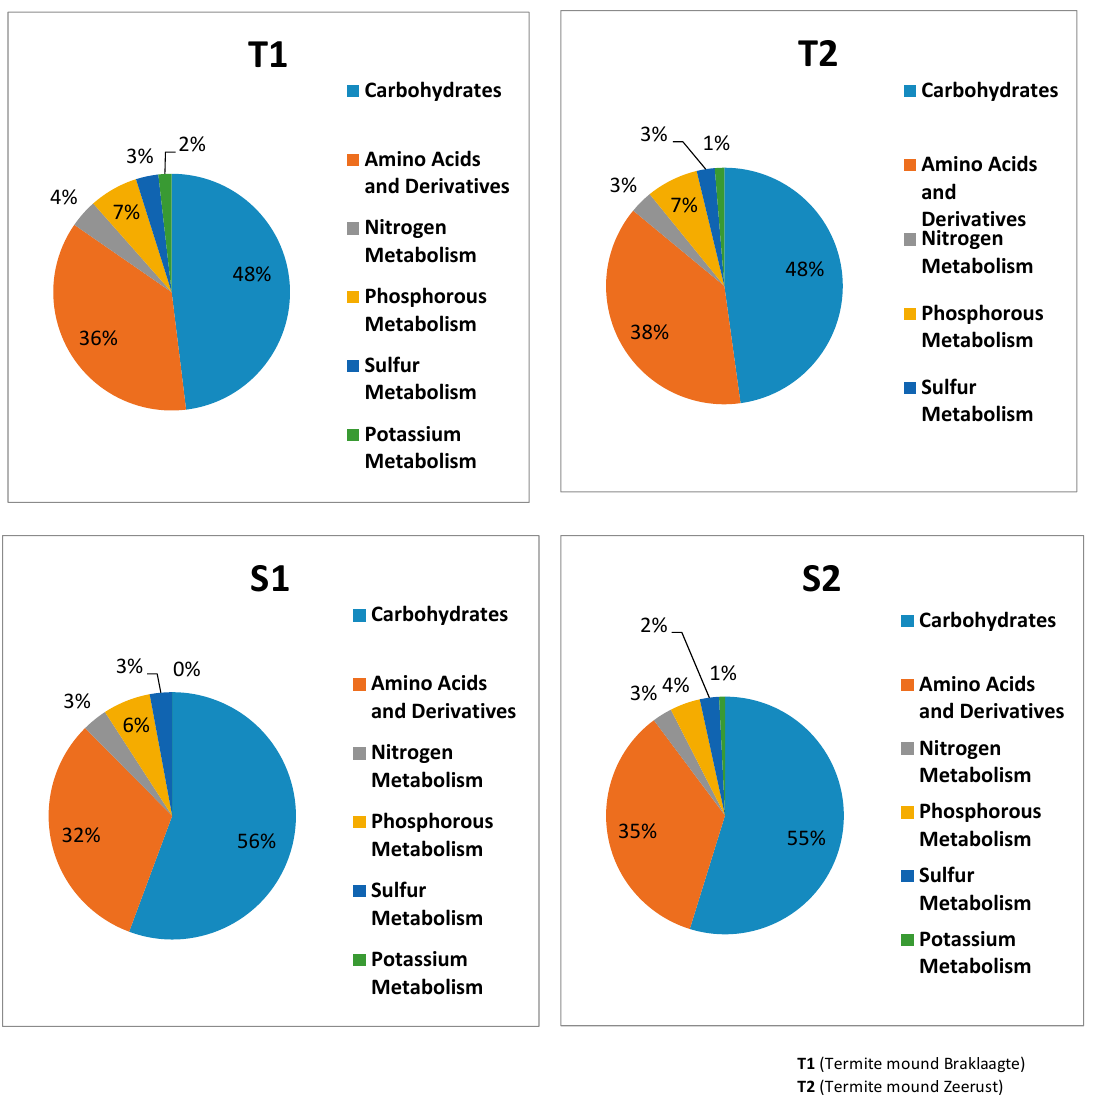
Figure 2. The relative abundance of the major functional categories in each soil sample.